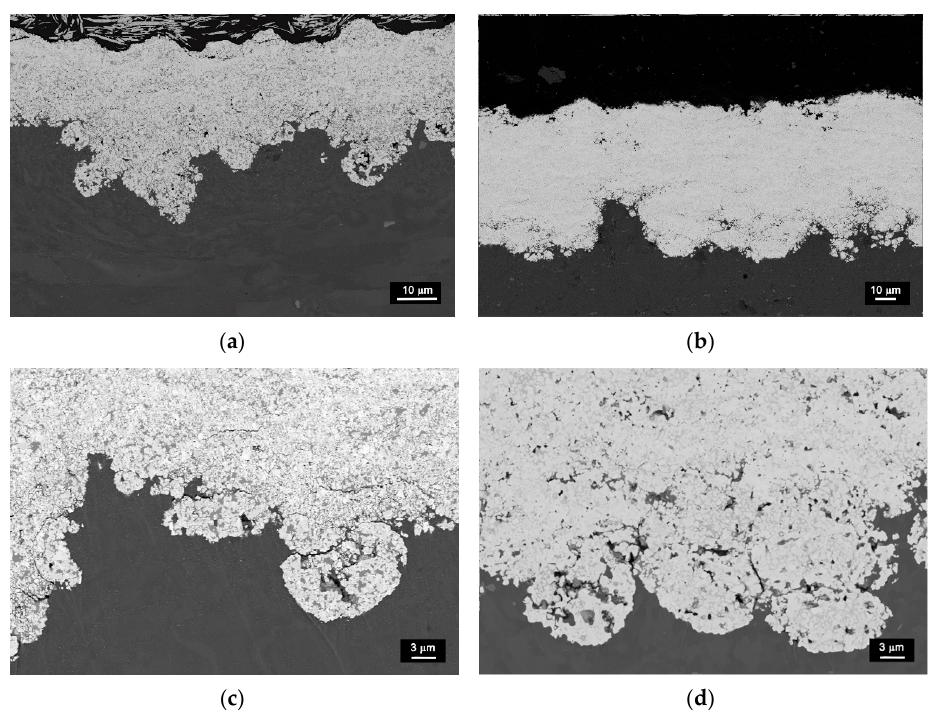
Figure 3. Cross section of ( a ) CGS and ( b ) HVAF WC-12Co coatings, and ( c , d ) respective coating– substrate interfaces.